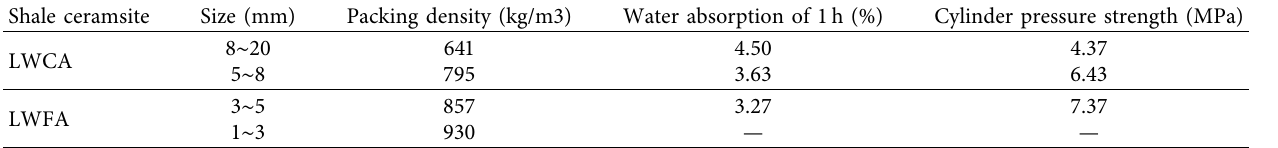
Table 1: The properties of lightweight